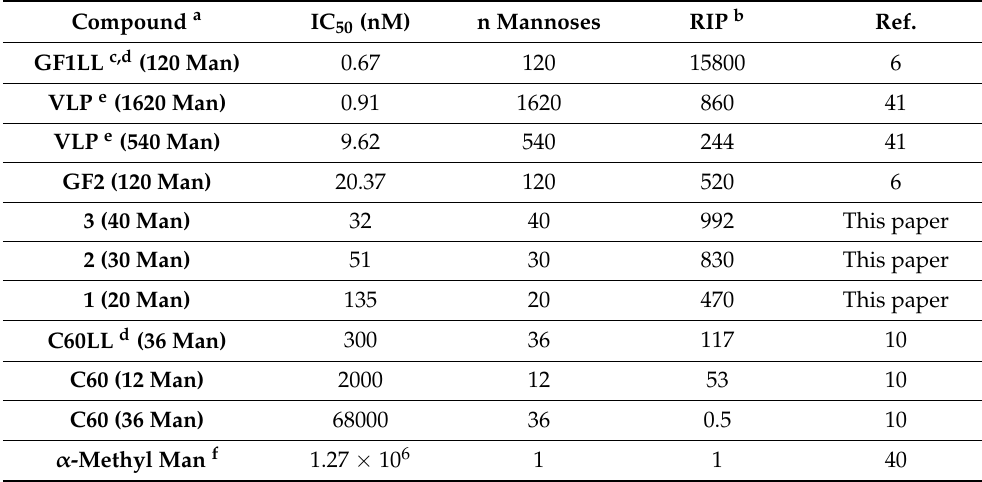
Table 1. Comparison of IC 50 values and relative inhibitory potency of different mannosylated multivalent compounds in inhibition studies using pseudotyped Ebola virus particles. Compound a IC 50 (nM) n Mannoses RIP b Ref. GF1LL c,d (120 Man) VLP e (1620